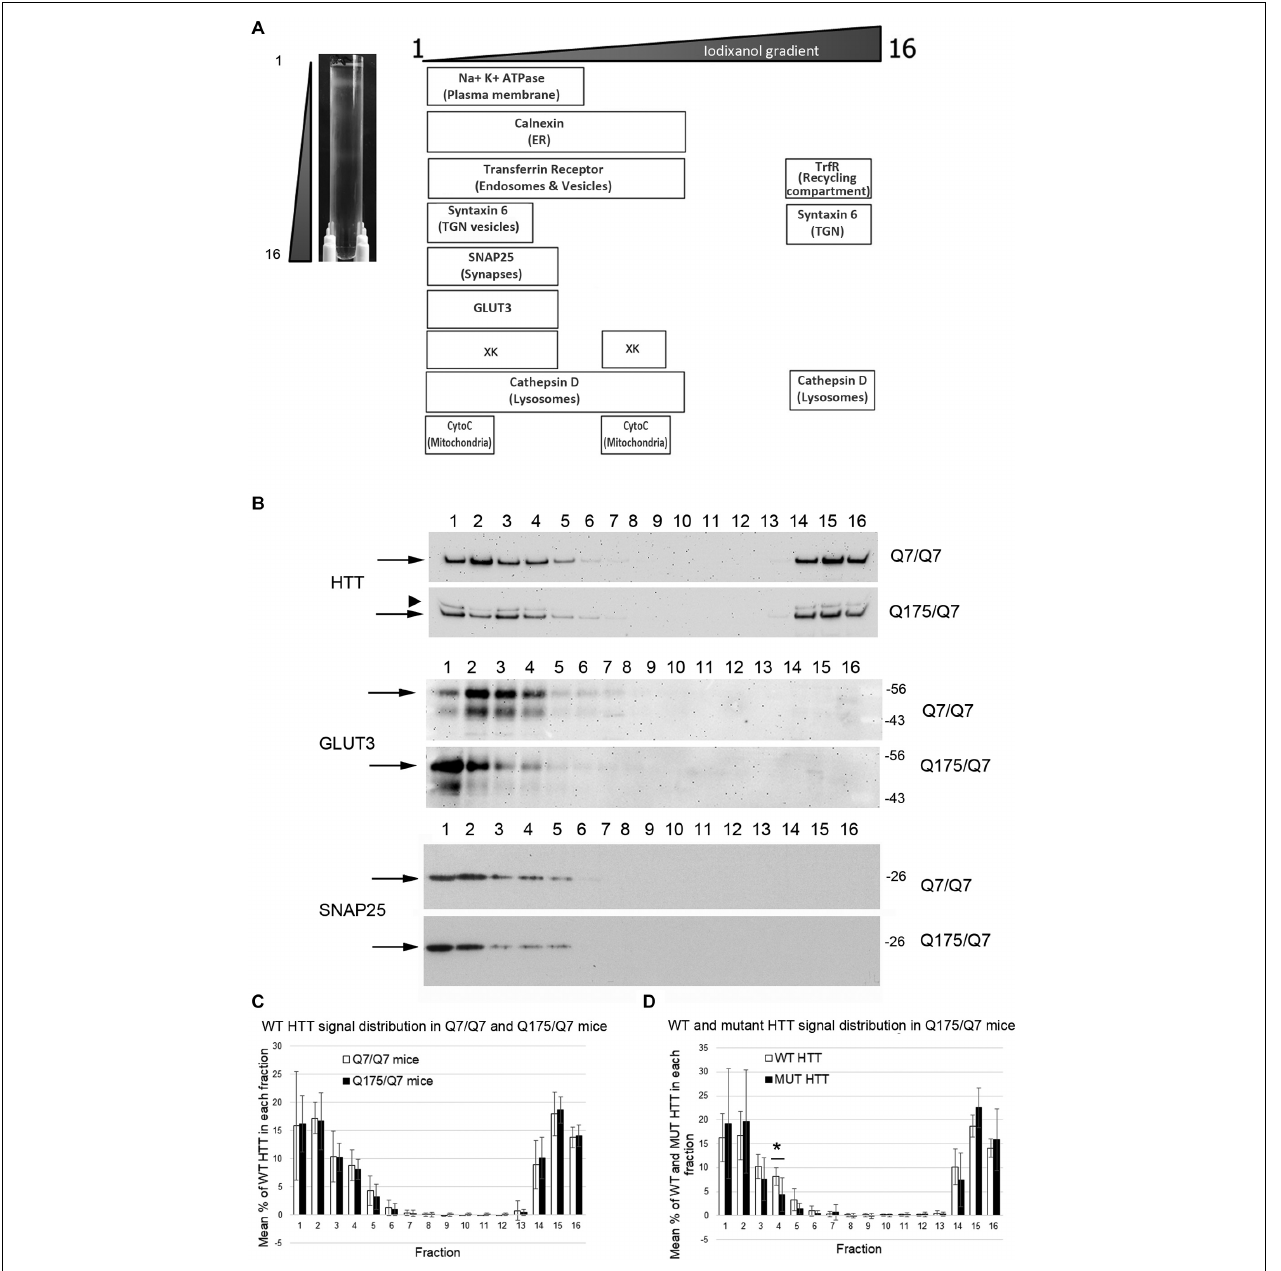
FIGURE 1 | Subcellular fractionation by continuous iodixanol density gradient ultracentrifugation of 6-month old Q7/Q7 and Q175/Q7 HD mouse striatum. (A) Striata were fractionated as described in section “Materials and Methods.” Picture at left shows ultracentrifugation tube after equilibration of compartments by centrifugation; banding pattern indicates successful fractionation of cellular components. Fractions 1–16 were removed from top to bottom as indicated. Fractions were assessed by SDS-PAGE and western blot analysis using the cell compartment markers indicated at top right to ensure complete separation. Equal volumes of each fraction were loaded per lane. (B) Representative images of western blots detecting Huntingtin (HTT) (WT and mutant (arrowhead)), GLUT3, and SNAP25. HTT distributes to light fractions 1–5 and co-fractionates with a marker of pre-synaptic compartment, SNAP25 and to dense fractions 14–16. GLUT3 co-fractionates in fractions 1–4 and shows a marked shift in the peak signal intensity between Q7/Q7 and Q175/Q7 HD resulting in an increase in signal for GLUT3 in Q175/Q7 in fraction 1 and a reduction in fractions 2–4. (C) Pixel intensity analysis of western blots for WT HTT. Bar graph shows mean percent ± SD of WT HTT in each of 16 fractions as a percent of total WT HTT signal summed across all fractions (1–16). White bars show WT HTT in Q7/Q7 mice and black bars show WT HTT in Q175/Q7 striata. There was no significant difference in WT HTT signal as percent of total signal between Q7/Q7 and Q175/Q7 mice for any fraction. (D) Pixel intensity analysis of western blots for mutant HTT and WT HTT in fractions from Q175/Q7 striata. Bar graph shows percent ± SD of WT HTT (white bars) and mutant HTT (black bars) signal in each of 16 fractions as a percent of total WT and mutant HTT signal summed across all fractions (1–16) in Q175/Q7 6-month old mice. There is a significant difference between WT and mutant HTT signal as a percent of total signal in fraction 4 (* p = 0.0266, unpaired t -test, N = 7).